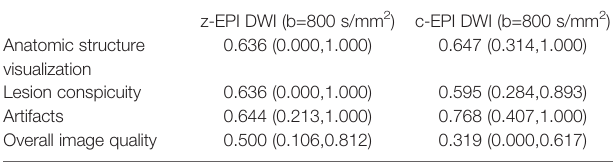
TABLE 3 | Inter-reader agreements of qualitative image quality